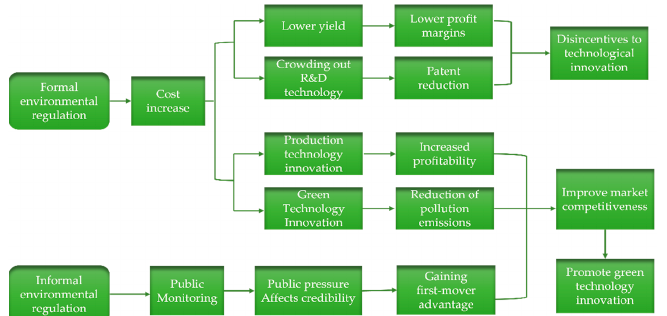
Figure 1. The mechanism of dual environmental regulation on green technology innovation.